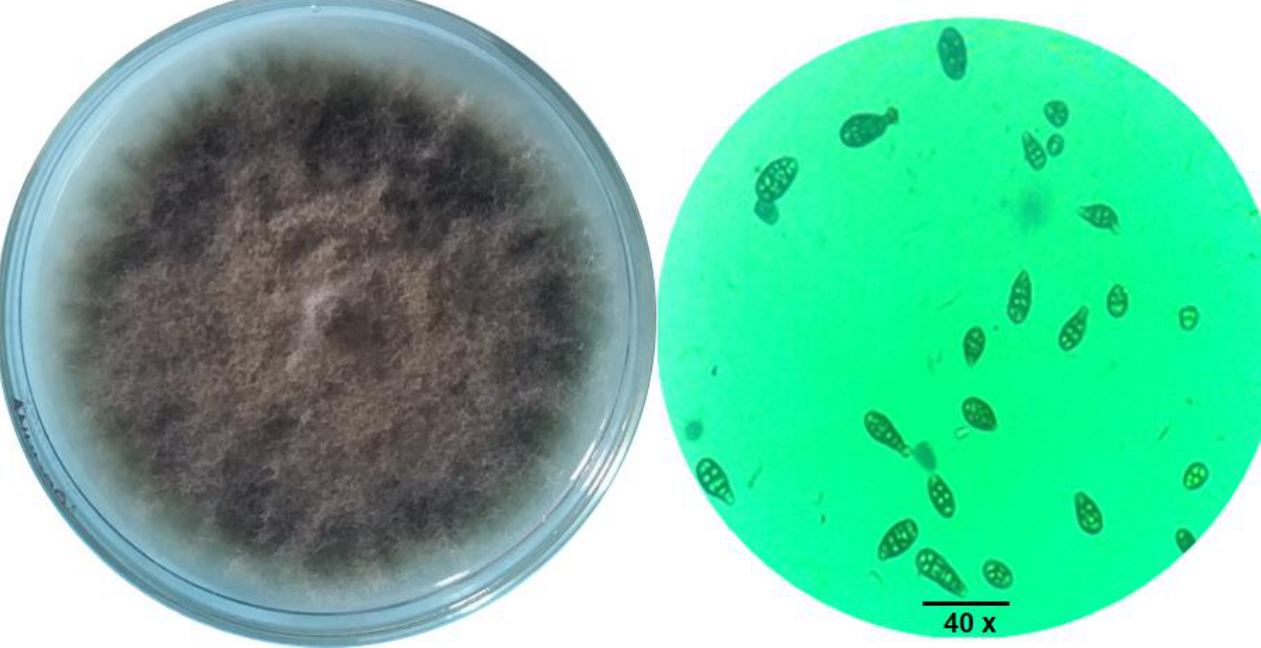
Figure 3. Colonial morphology and growth pattern of Alternaria solani on PDA medium (left), and microscopic examination of conidial spores at 40× magnification (right).